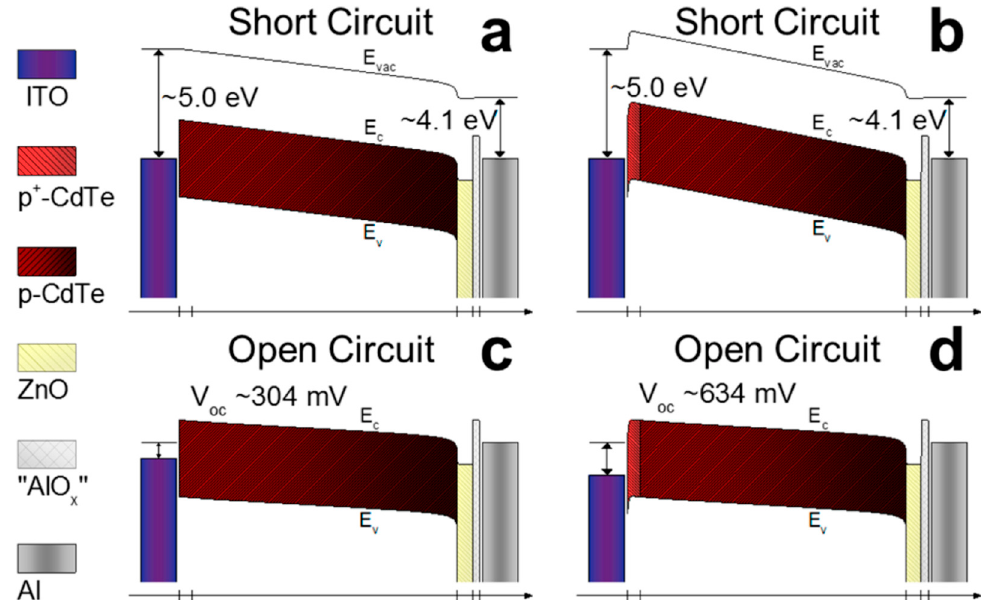
Figure 4. ( a , c ) Band diagrams of modeled CdTe solar cells with ITO/“CdTeOx”/CdTe/ZnO:In//“AlOx”/Al geometry at equilibrium (a) and V oc (c) before current/light soaking. ( b , d ) Band diagrams of modeled CdTe solar cells with a heavily doped CdTe layer between ITO and CdTe at equilibrium (b) and V oc (d) before current/light soaking [12]. Copyright 2017 American Chemical Society.